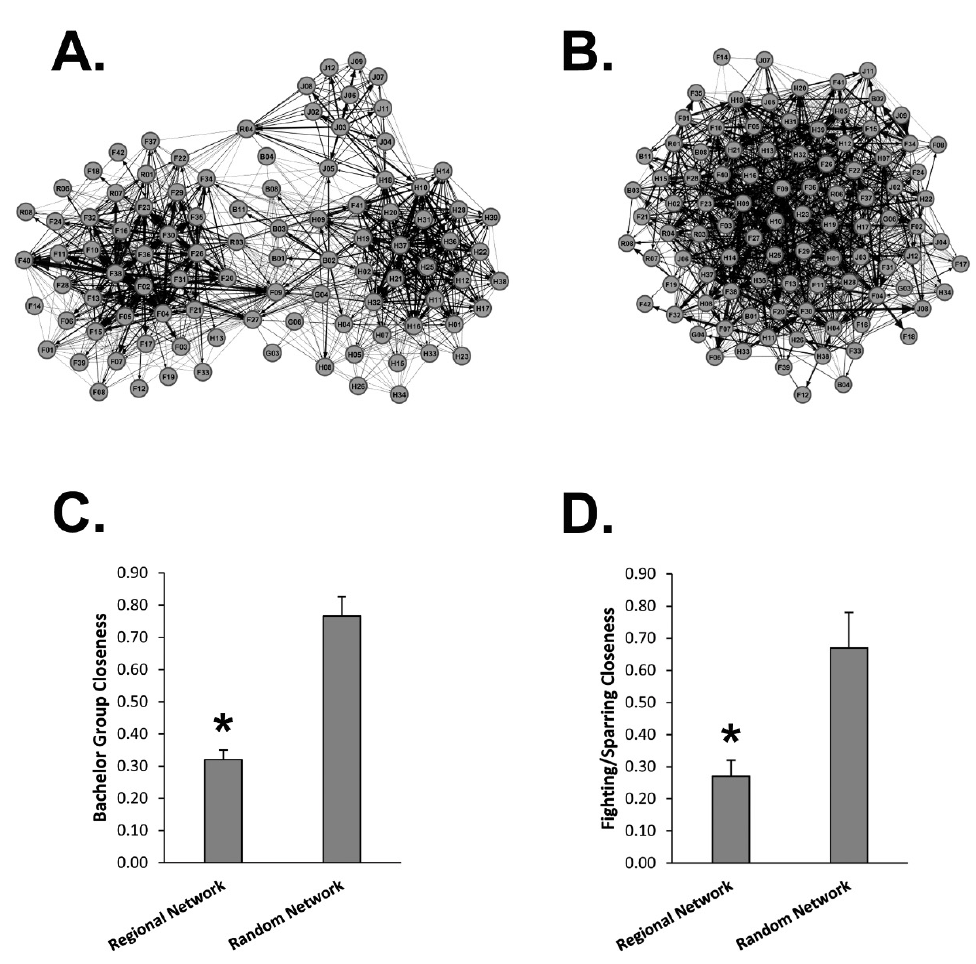
Figure 3. Regional Network vs. Random Network. ( A ) Shown is the Regional Network graph derived from scraping data at Site 1, Site 2, Site 3 and all boundary locations. ( B ) Shown is the Random Network graph derived from randomization of the Regional Network data. ( C ) The graph displays the Avg ± Stdev of closeness scores between bachelor pairs measured using the Regional Network and the Random Network (n = 29). ( D ) The graph displays the Avg ± Stdev of closeness scores between sparring or fighting pairs measured using the Regional Network and the Random Network (n = 9). Statistical analysis was performed using a one-way ANOVA test, where * p < 0.05 was considered significant.